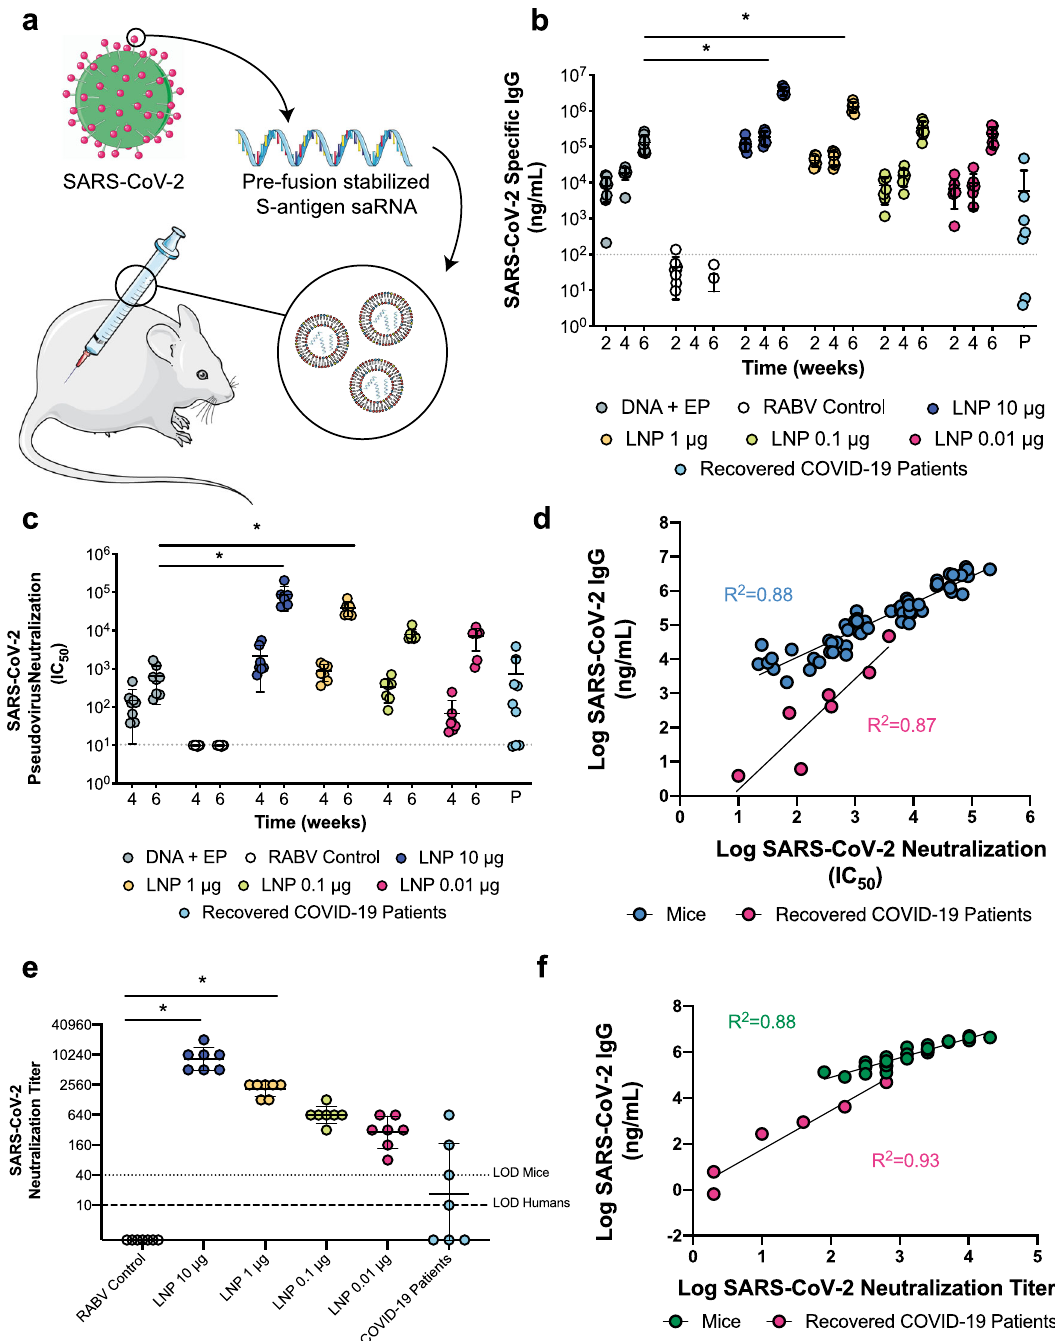
Fig. 1 Antibody quanti fi cation and neutralization of a SARS-CoV-2 saRNA vaccinated mice compared to COVID-19 recovered patients. a Schematic of vaccination of BALB/c mice with saRNA encoding pre-fusion stabilized spike protein in LNP, b SARS-CoV-2 speci fi c IgG responses in mice vaccinated with doses of LNP-formulated saRNA ranging from 0.01 – 10 μ g of saRNA with n = 7 biologically independent animals and COVID-19 recovered patients with n = 9 biologically independent samples, c SARS-CoV-2 pseudotyped virus neutralization of sera from BALB/c mice vaccinated with doses of LNP- formulated saRNA ranging from 0.01 – 10 μ g of saRNA with n = 7 biologically independent animals and COVID-19 recovered patients with n = 9 biologically independent samples, d Correlation between SARS-CoV-2-speci fi c IgG and SARS-CoV-2 neutralization IC 50 for vaccinated mice ( n = 7 biologically independent animals) and recovered COVID-19 patients ( n = 9 biologically independent samples), e SARS-CoV-2 viral neutralization of sera from BALB/c mice vaccinated with doses of LNP-formulated saRNA ranging from 0.01 to 10 µ g of saRNA with n = 7 biologically independent animals, f Correlation between SARS-CoV-2-speci fi c IgG and SARS-CoV-2 wild type viral neutralization titers for vaccinated mice ( n = 7 biologically independent animals). Electroporated pDNA (DNA + EP) was used as a positive control while saRNA encoding the rabies glycoprotein (RABV) in pABOL was used as a negative control (RABV control). * indicates signi fi cance of p < 0.05 using a two-way ANOVA adjusted for multiple comparisons. Line and error bars indicated mean ± SD. Components of this fi gure were created using Servier Medical Art templates, which are licensed under a Creative Commons Attribution 3.0 Unported License; https://creativecommons.org/licenses/by/3.0/.